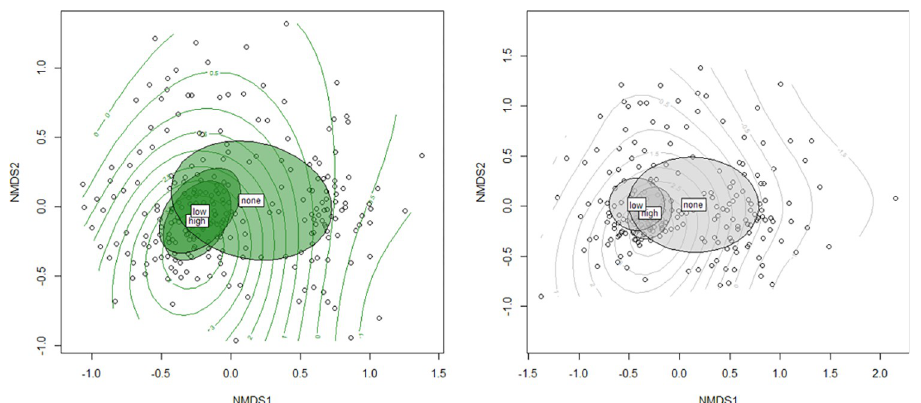
Fig 3. Communities for all sites from 2000, 2005, and 2010 during the spring season are plotted as green points in the left panel where communities from the winter season are plotted on the right. Clusters for “high”, “low”, and no restaurants are shown as ellipses overlapping the sites. Contour lines are used to display the gradient of increasing